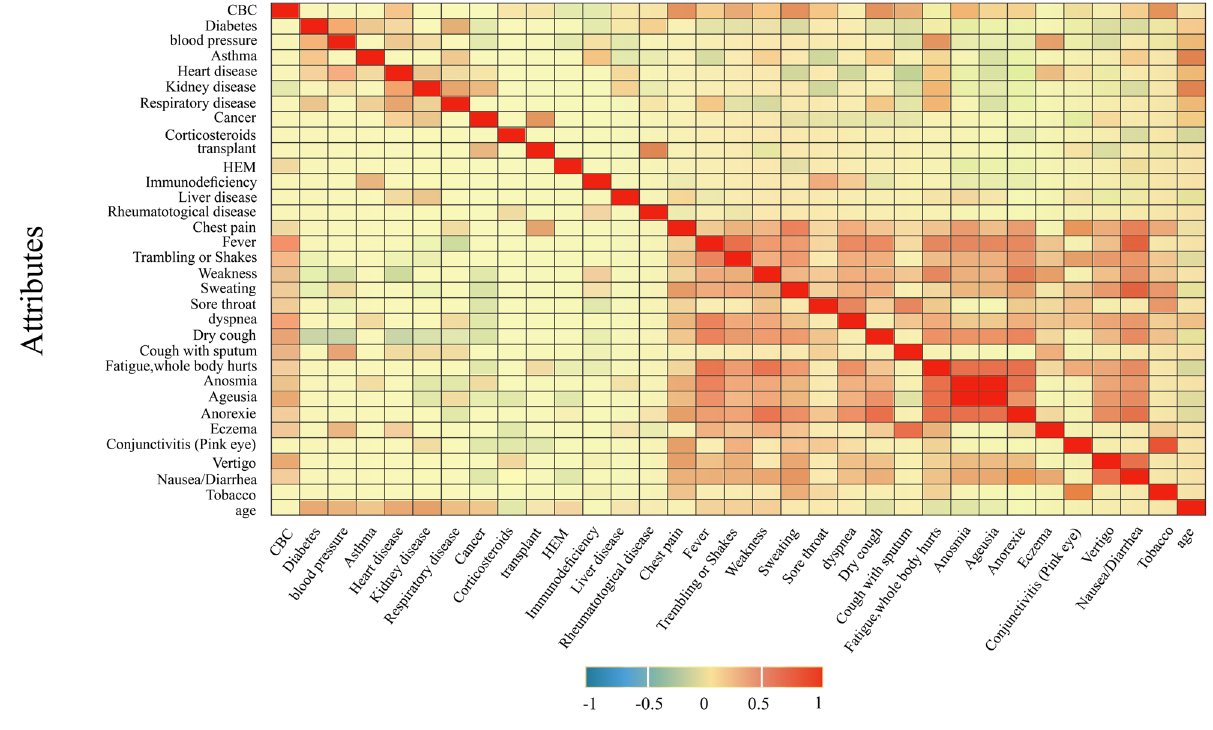
Figure 4. Correlation between dataset features.